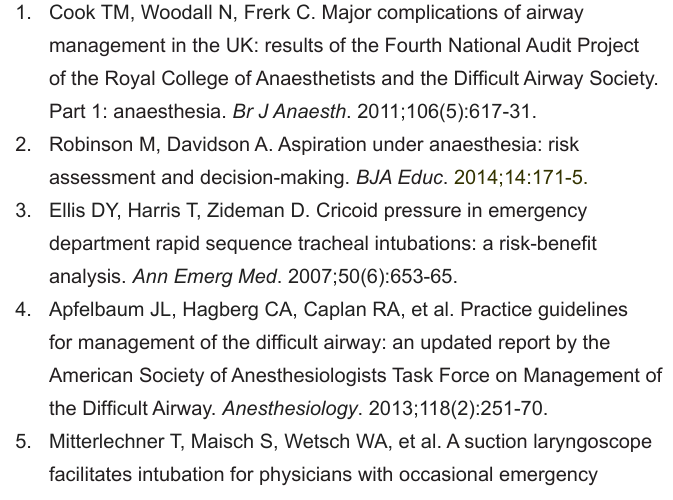
Data are median (interquartile range). PGY , post graduate